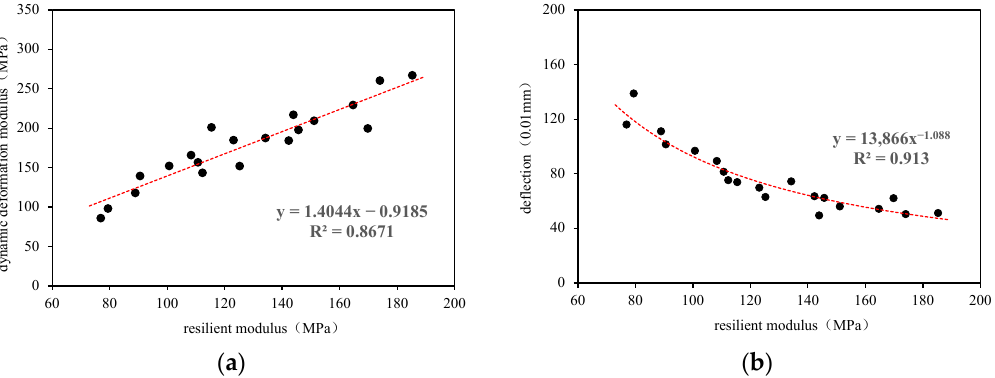
Figure 8. Correlation between different performance indexes of modified red mud subgrade. ( a ) is correlation between dynamic deformation modulus and resilience modulus, ( b ) is correlation between deflection and resilience modulus.